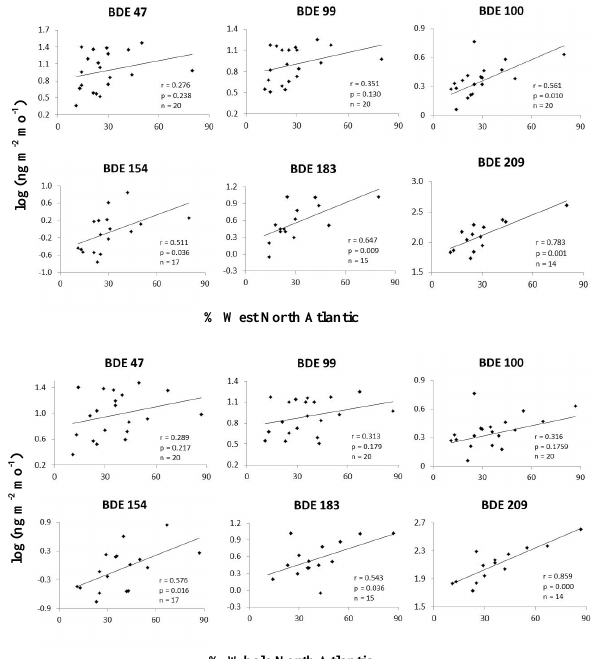
Fig. 5. Relationship between % of North Atlantic air masses during the collection period of each sample and PBDE atmospheric de- position fluxes in Redon. Western North Atlantic trajectories only consider those air masses flowing from the west without passing over British Isles and France. Whole North Atlantic includes all air masses coming from the North Atlantic arriving to this site.